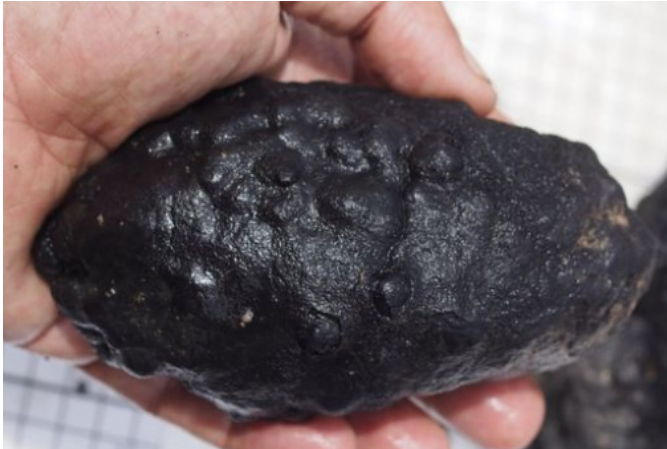
Figure 1. Manganese nodule collected in the Solwara 1 project (Source: [18]).